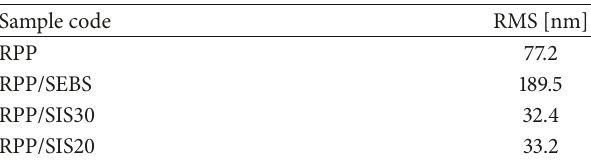
Table 3: Roughness values for the samples calculated from AFM